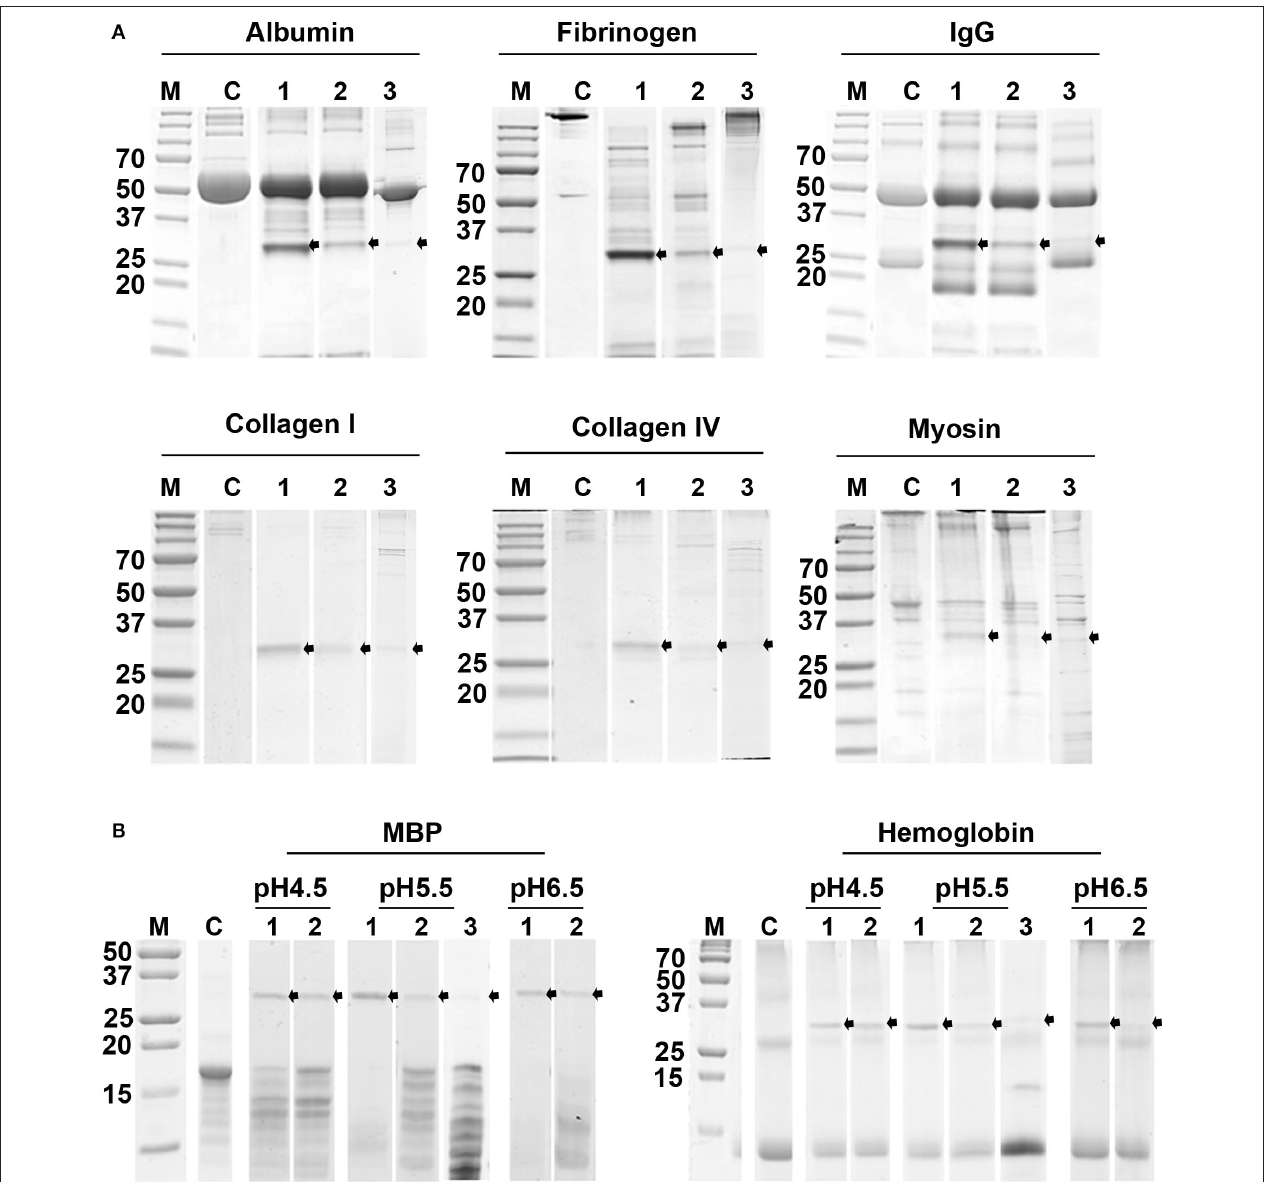
FIGURE 10 | Digestion of selected protein substrates by recombinant TrCB1 forms. The substrates (0.5 mg/ml) were incubated for 6h with pepTrCB1 forms (1 µ g) at 37 ◦ C. Aliquots (20 µ l) of the resulting hydrolysates were separated by SDS-PAGE and stained with Coomassie Brilliant Blue. (A) Incubation of pepTrCB1.1, pepTrCB1.4 and pepTrCB1.6G/C (lanes 1–3, respectively) at pH 5.5 with albumin, fibrinogen, collagen type I, collagen type IV and myosin. (B) Incubation of pepTrCB1.1, pepTrCB1.4 and pepTrCB1.6G/C (lanes 1–3, respectively) at pH 4.5–6.5 with myelin basic protein (MBP) and hemoglobin. C, controls (substrates without enzyme). The starting amount of the peptidases was equal in all samples; note the autodegradation of the enzymes under given conditions, resulting in weaker bands especially in TrCB1.6G/C. Arrows indicate the visible peptidase bands in the gels. M, markers of molecular size